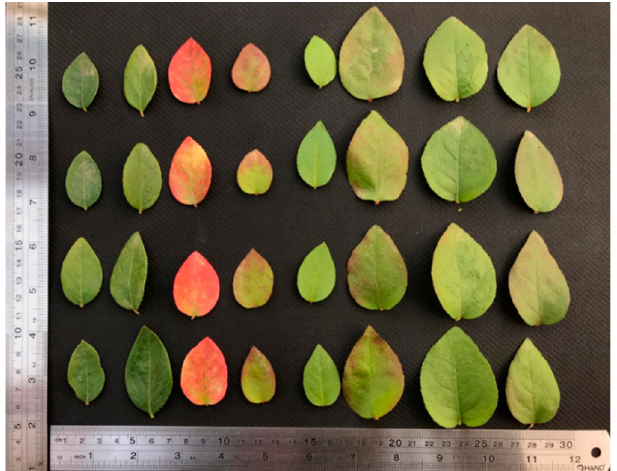
Figure 2. Example of genetic variability (morphology) evidence in the studied clones of blueberries regenerated in colchicine. Vertical: Replica leaves of individual clones. Horizontal: Blueberry clones under evaluation. Left: Donor genotype Duke.